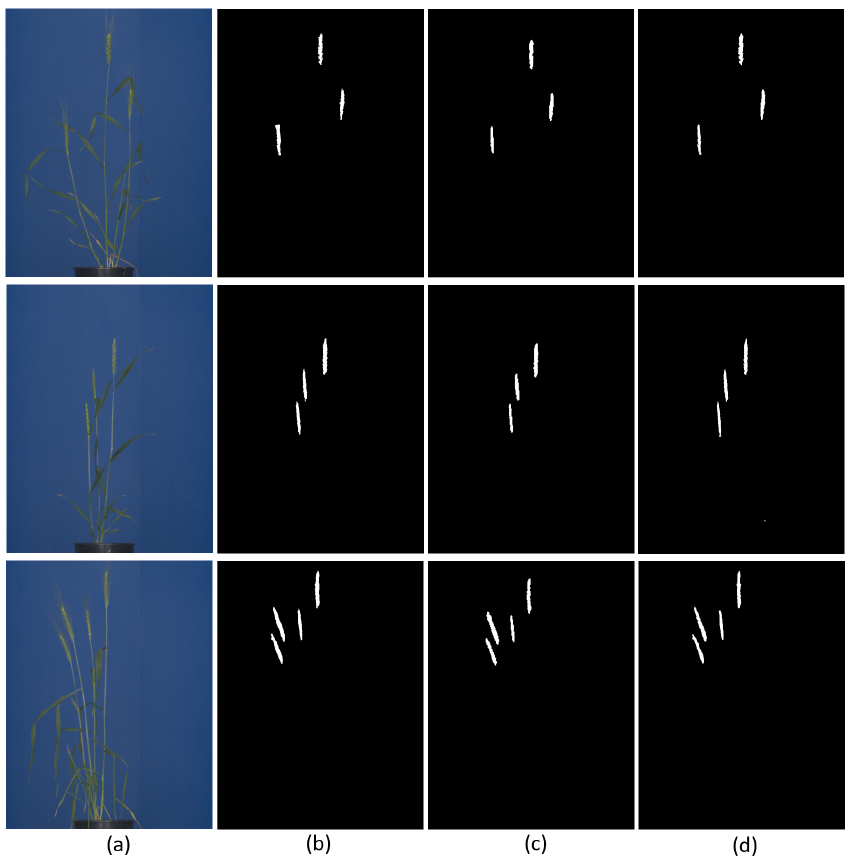
Figure 7. Examples of U-Net and DeepLabv3+ segmentation of spike images: ( a ) original test images, ( b ) ground truth binary segmentation of original images, and segmentation results predicted by ( c ) U-Net and ( d ) DeepLabv3+, respectively. The predominant inaccuracies in both NN models are associated with boundary pixels of spike followed false positive.